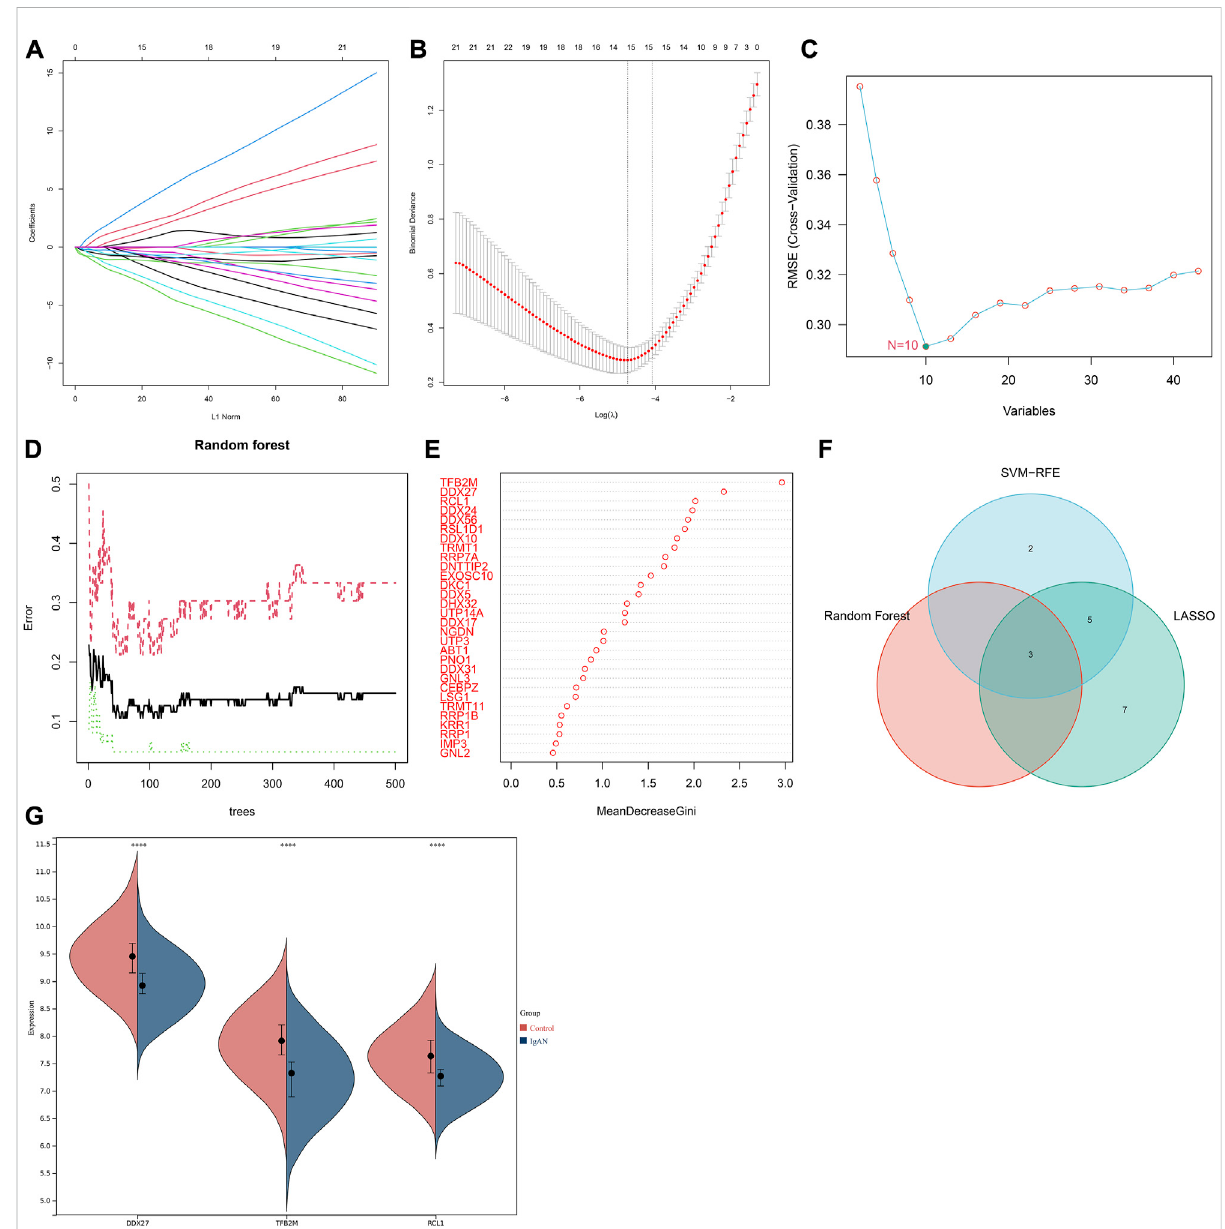
FIGURE 3 Integration of three machine learning algorithms to determine characteristic RBPs in IgA nephropathy. (A) The regression coef fi cient of each independent variable in the LASSO model. (B) Binomial deviance under different log(lambda) in the model. (C) SVM-RFE for feature section. (D) Random forest for screening characteristic genes. (E) The rank of genes according to the relative importance. (F) Venn diagram of the intersection results of characteristic genes from three machine learning approaches. (G) Expression of characteristic RBPs in IgA nephropathy and normal specimens (**** p < 0.0001). IgAN, IgA